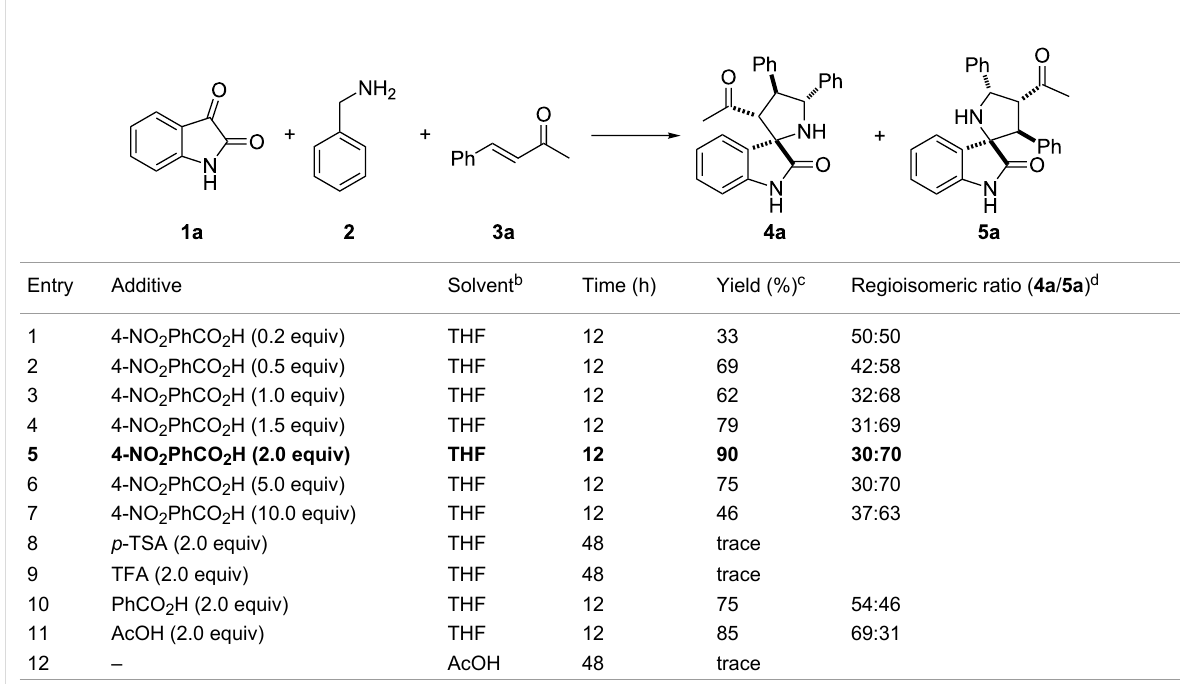
Table 2: 1,3-Dipolar cycloaddition reaction of isatin ( 1a ) and benzylamine ( 2 ) with benzylideneacetone ( 3a ) and acid additives a